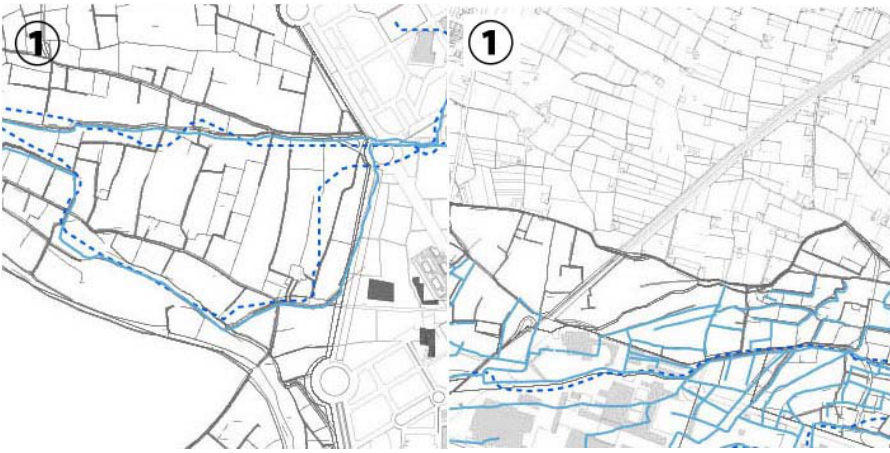
Figure 5. The areas labeled ①, the canals preserved their layout from 1883 to 1946. The canals in these areas are still used for agricultural irrigation systems.